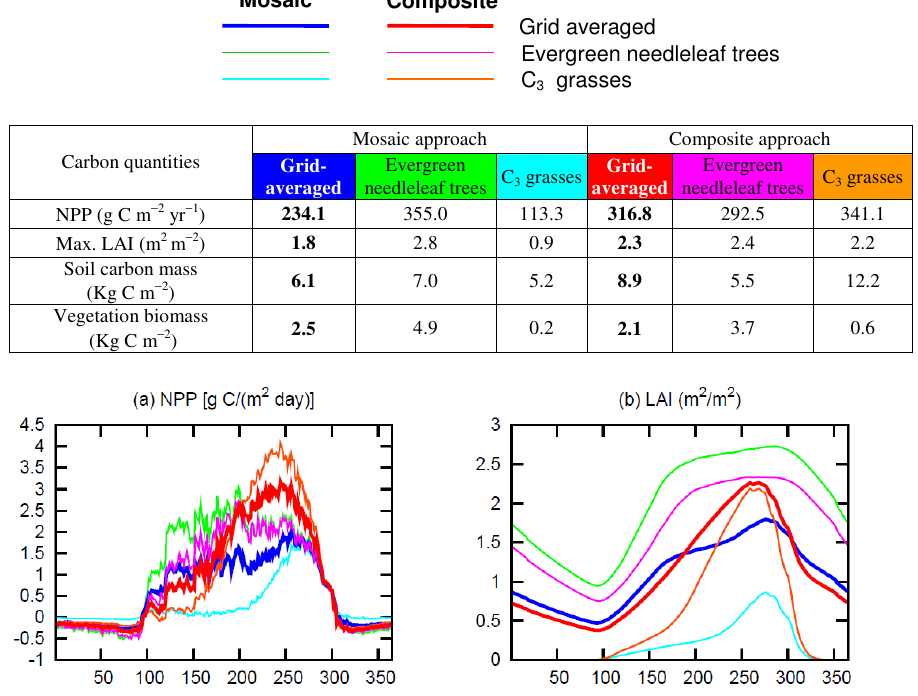
Fig. 4. Simulated daily averaged values of (a) NPP and (b) LAI for the Manitoba location for individual PFTs and grid-averaged values when using the two approaches. The table at the top summarizes the average annual values of NPP, vegetation biomass, soil carbon mass, and annual maximum values of LAI when using the two approaches. Table 1. Average annual values of primary energy fluxes at the Siberia location when using the composite and mosaic approaches. Mosaic approach Energy fluxes Grid